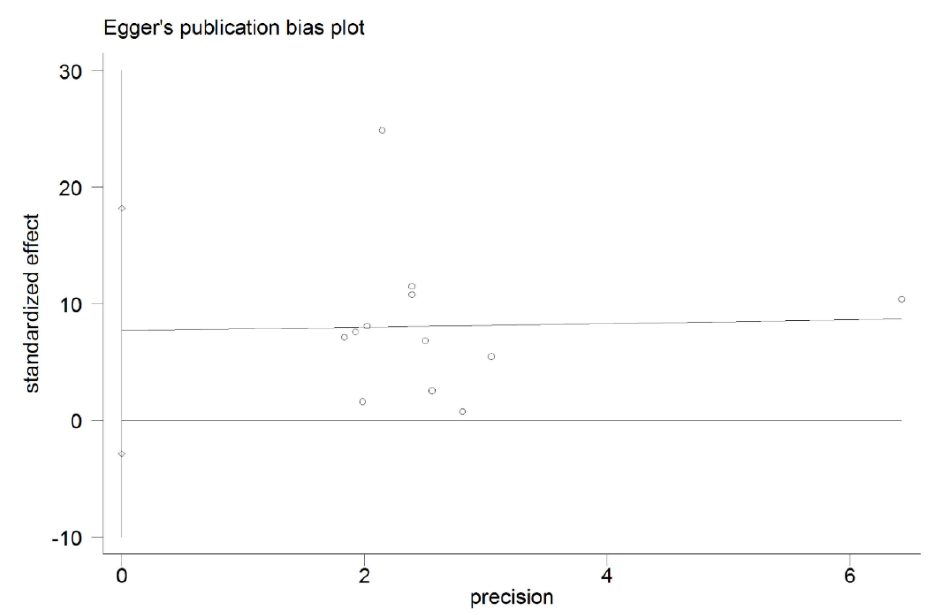
Figure 7. The Egger’s publication bias plot for the association between vitamin D deficiency and Graves’